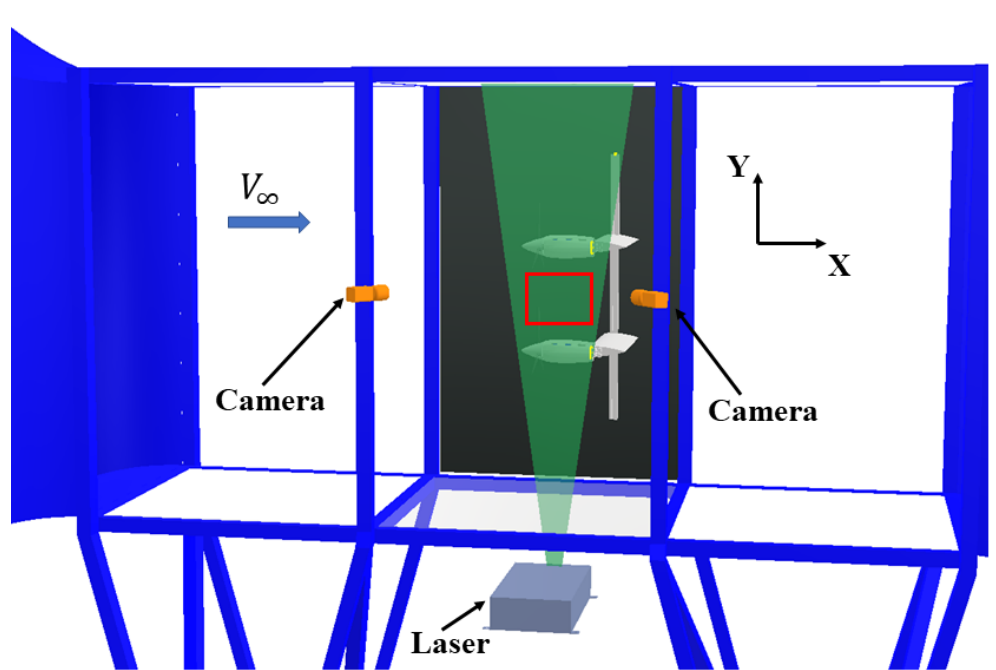
Figure 5. Stereo PIV set-up for measurements of side-by-side propellers interaction at the S. De Ponte wind tunnel. The area of investigation is depicted by red the rectangular zone The image pairs analysis was performed by PIVview 3C software developed by PIVTEC. In particular, the multigrid interrogation method [16] was used, starting from a 128 pixel × 128 pixel to a 16 pixel × 16 pixel interrogation window. An effective overlap of 50% of the interrogation window was considered in the PIV image pair post-processing, thus resulting in a spatial resolution of 1.7 mm between adjacent measurement points. Two upper propeller considered by phase-locked measurements. The resulting velocity fields